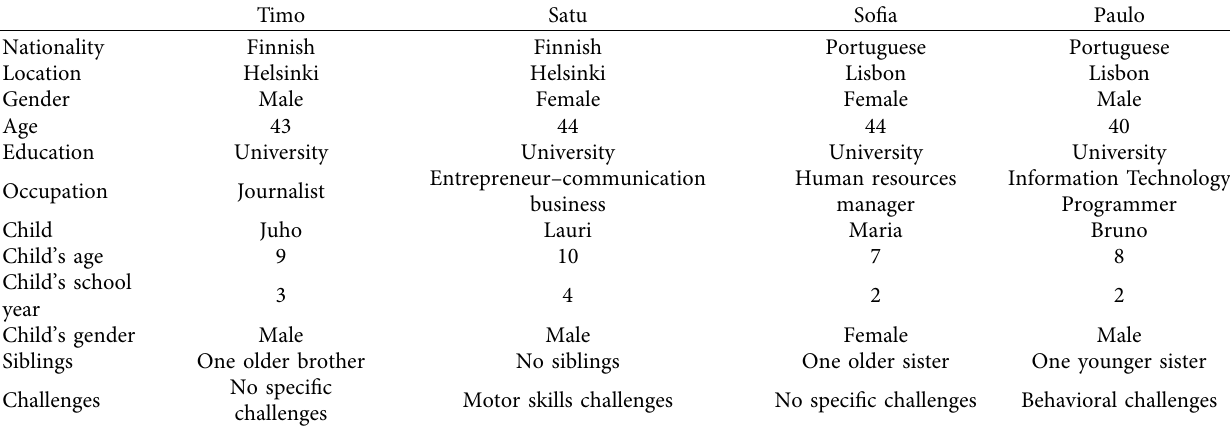
Table 1: Parents’ background